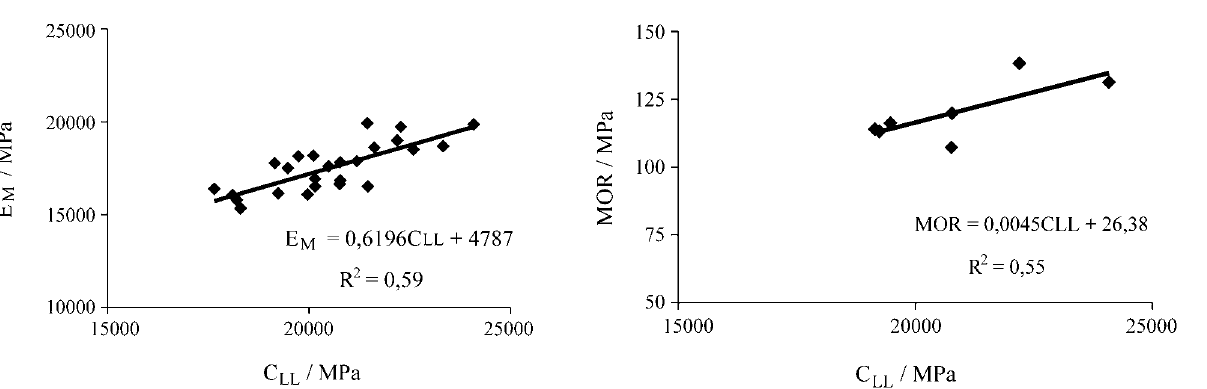
Figure 5. E M and MOR as a function of C LL for the “jatobá”